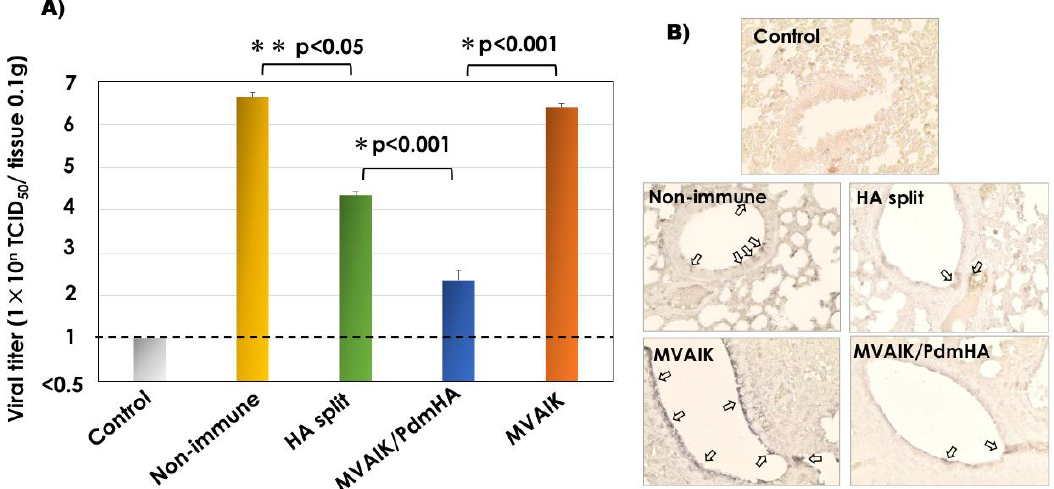
Figure 5. Recovery of infectious influenza virus from lung tissues after the challenge. ( A ) Infectious titers from 0.1g of lung homogenates from control, non-immune infection, HA split vaccine, MVAIK/PdmHA, and MVAIK (empty vector) groups. Horizontal dotted line shows the detection limit. Vertical column represents mean + SE. ( B ) Detection of the influenza HA antigen. Arrows show positive influenza HA